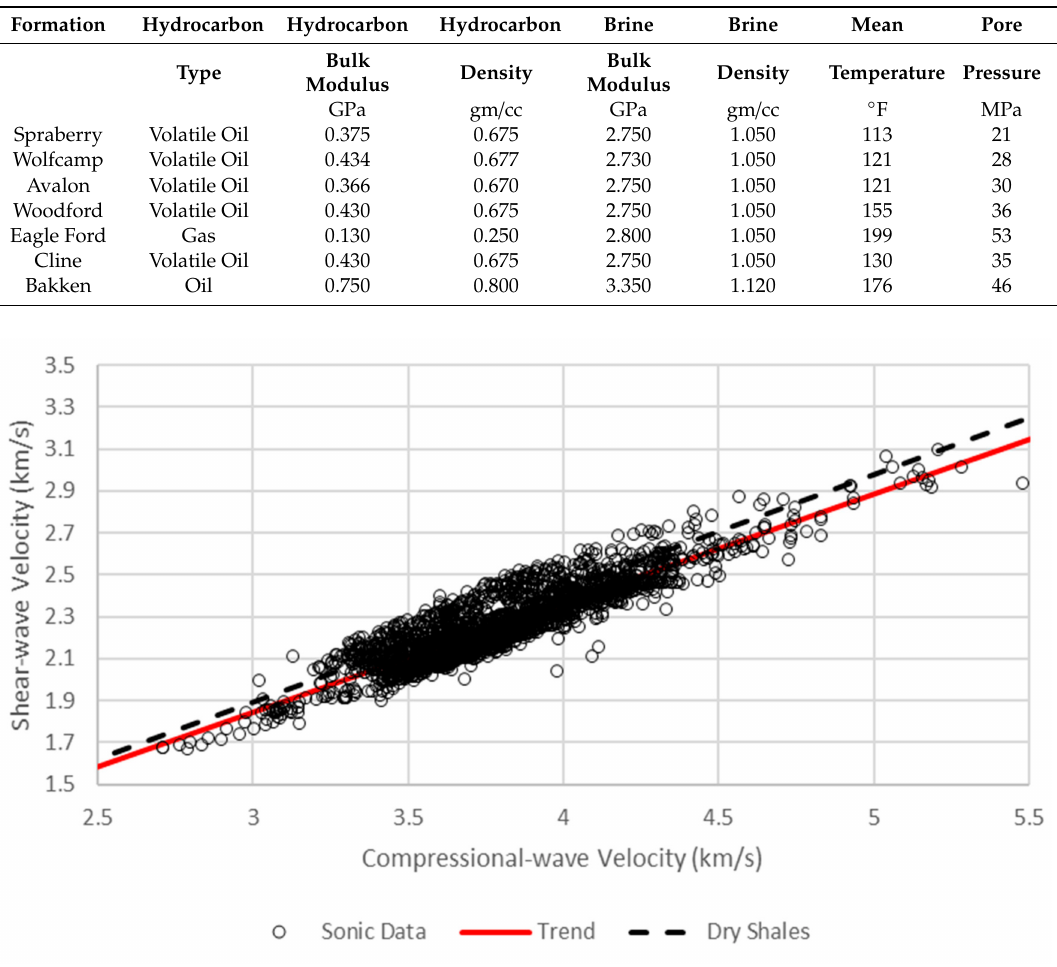
Figure 2. Shear-wave velocity (V s )versus compressional-wave velocity (V p ) cross plot for sonic log measurements in seven organic-rich shale reservoirs containing fluid hydrocarbons with water saturations below 70%. The red solid line is the least mean-squared error (LMSE) fit to the data (V s = 0.520 V p + 0.287 km / s). The correlation coe ffi cient is 0.9 and the mean absolute error is 2.9%. The regression is highly statistically significant with an F-test (ratio of explained to unexplained variance) of over 8000 and sig F (the probability that the calculated correlation is fortuitous) of zero. The dashed black line is the LMSE trend for dry organic shale laboratory measurements reported in [9]. The point cloud contains multiple closely spaced nearly parallel trends that are slightly o ff set from the general trend in di ff erent formations (see Table